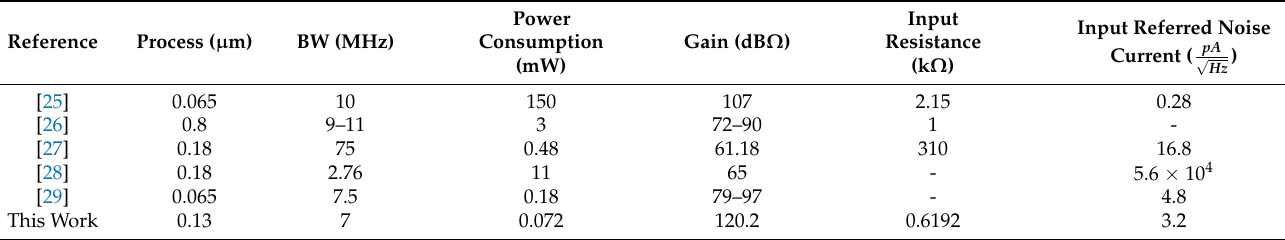
Table 2. Performance of the proposed receiver with previously reported